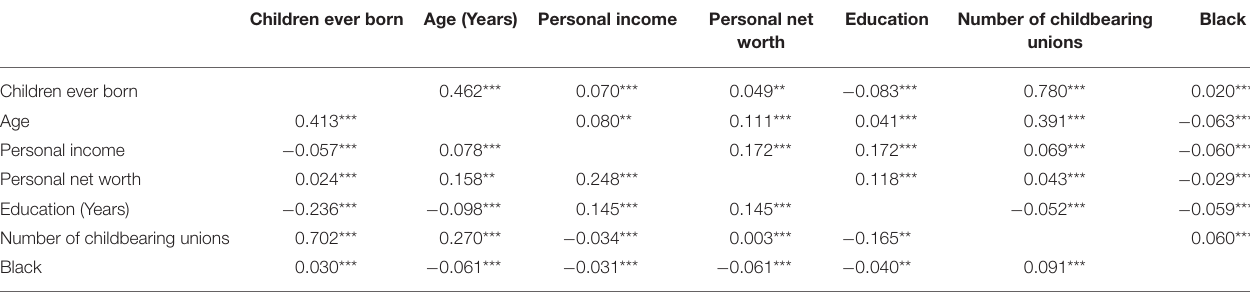
TABLE 2 | Pearson correlation coefficients all cases, all variables.